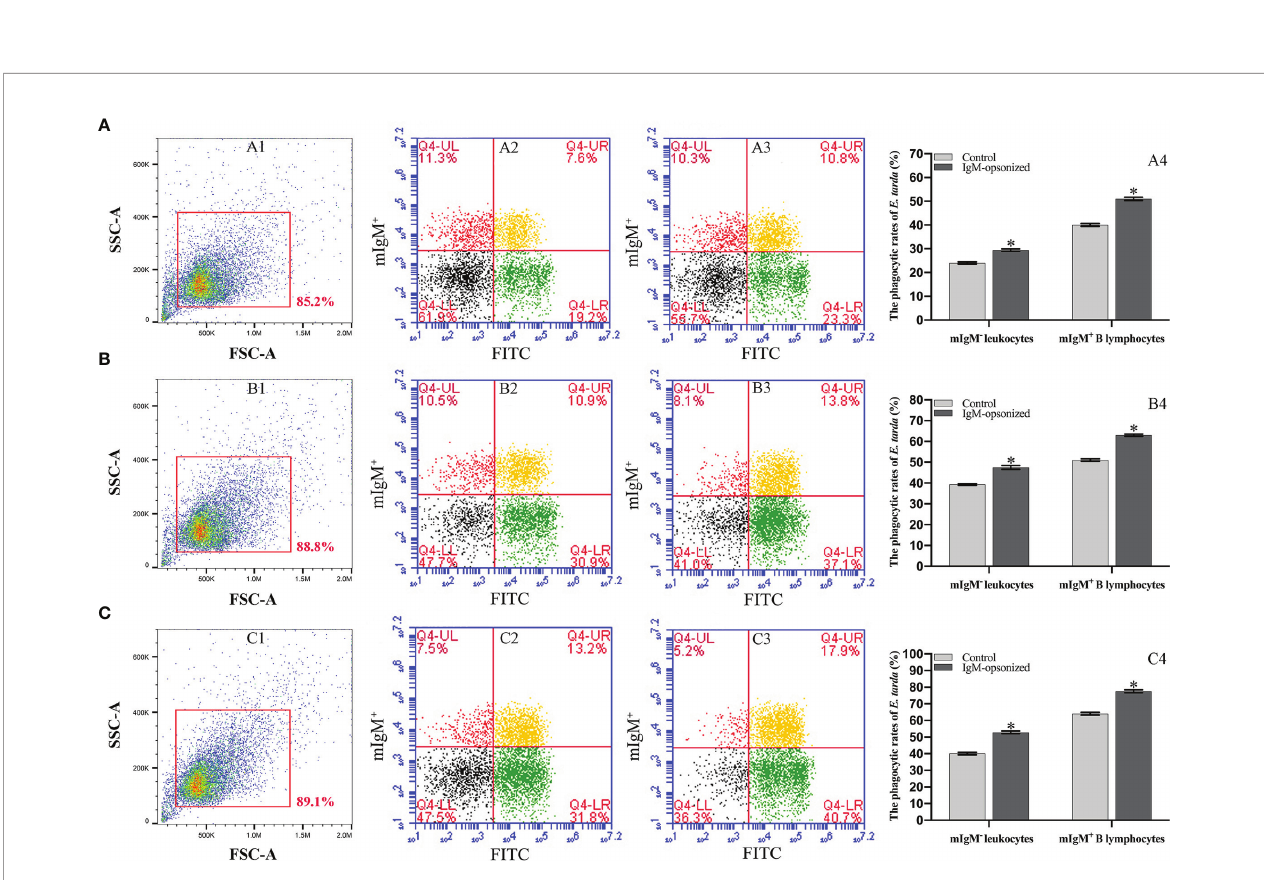
FIGURE 2 | Analysis of phagocytosis rates of fl ounder mIgM + B lymphocytes after incubation with opsonized E . tarda using healthy fl ounder sera and antisera by fl ow cytometry. (A – C) Phagocytosis rates of mIgM + B lymphocytes after incubation with E . tarda for 1 (A) , 3 (B) or 5 h (C) . 1: FSC/SSC plots of PBLs. Fluorescence scatter plots of PBLs incubated with opsonized E . tarda using healthy fl ounder sera (2) and antisera (3). 4: Phagocytosis rates of mIgM + B lymphocytes and mIgM - leukocytes summarized from the fl uorescence scatter plots. Error bars indicate the standard deviation of the three biological replicates. The asterisks on the bars represent the statistical difference of the phagocytosis rates compared to the control group ( p <